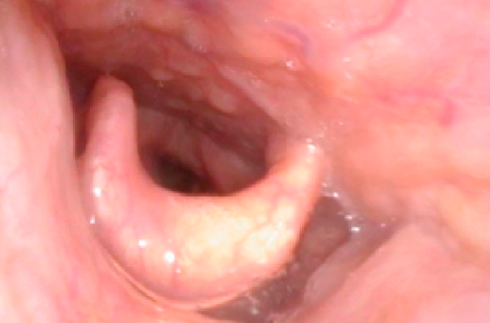
Figure 2. Nasendoscopy picture in MPS I showing a high larynx, large epiglottis touching the soft palate, vallecula cannot be seen, and only the posterior glottis is visible.